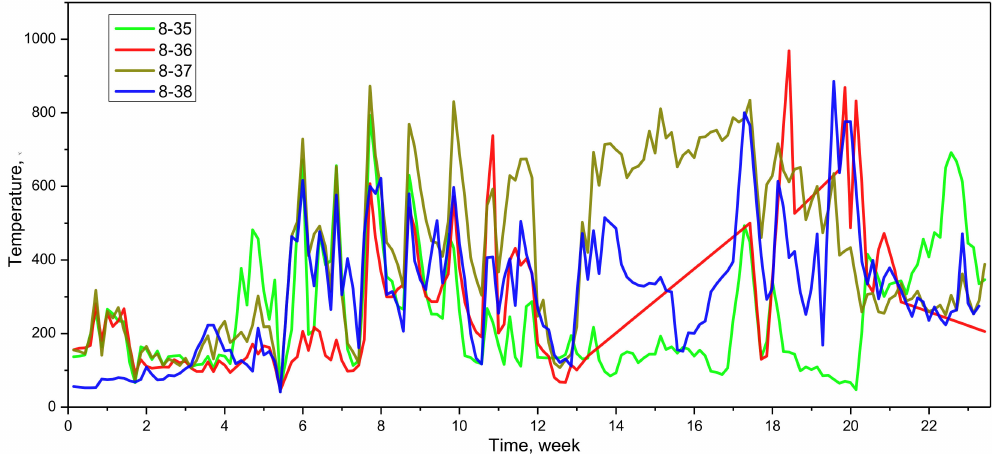
Figure 9. Changes in temperature after copper staves were